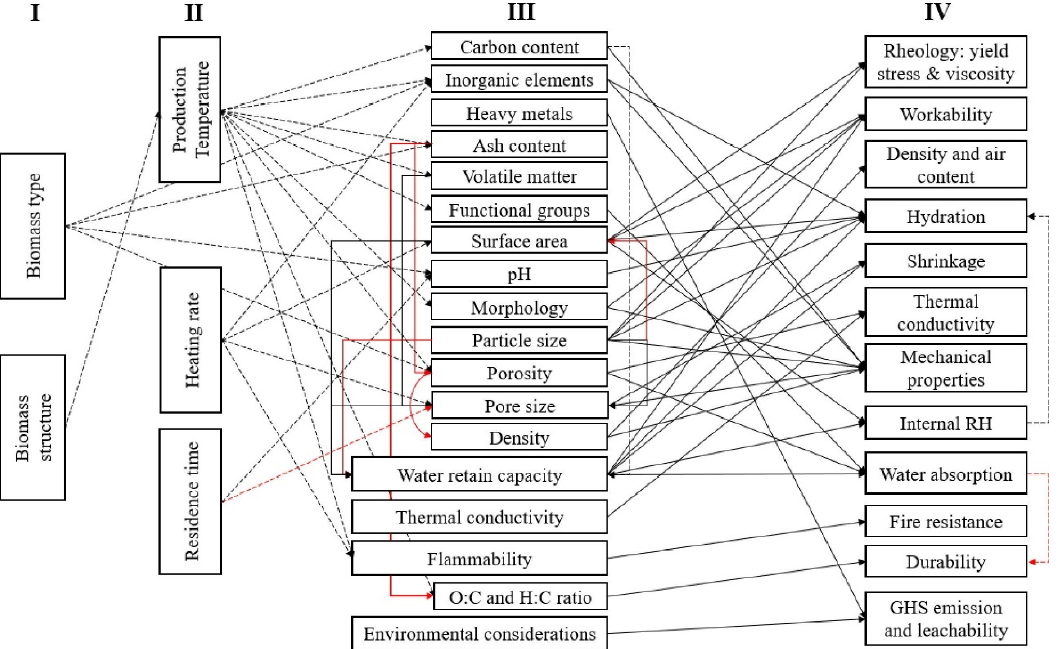
Figure 2. Detailed map describing factors influencing biochar and cement composite